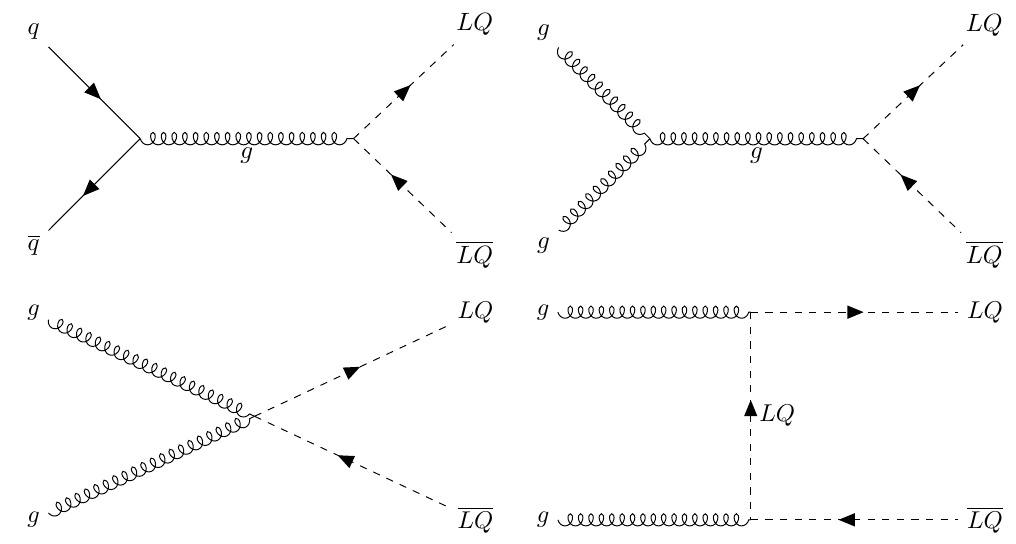
Figure 2 . Leading order Feynman diagrams for the pair-production of LQs, leading to (cid:12)nal states with two (cid:28) leptons and two b